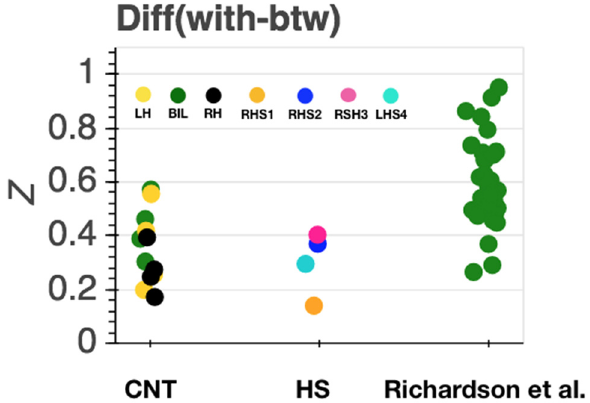
Figure 5. Differences in within and between network connectivity strength per sample CNT (left), HS (middle), comparison sample form Richardson et al. (right) [7]. Each datapoint corresponds to one subject. For CNT, type of ROI is color coded (bilateral: green; LH: yellow; RH: black), for HS, subjects are color coded (RHS1 orange, RHS2: blue, RHS3: pink, LHS4 turquoise), for Richardson et al. comparison data, all data are from bilateral (green) ROIs per